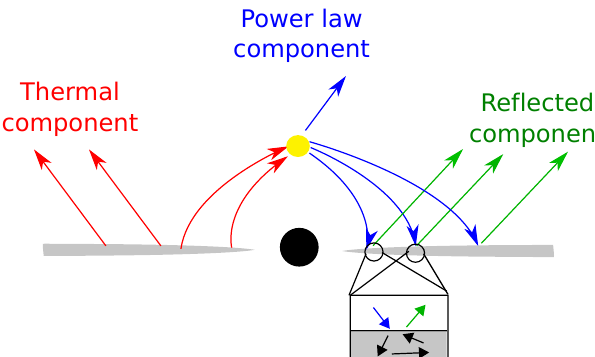
Figure 1. Sketch of the disk-corona model and the reflection process. From Ref.